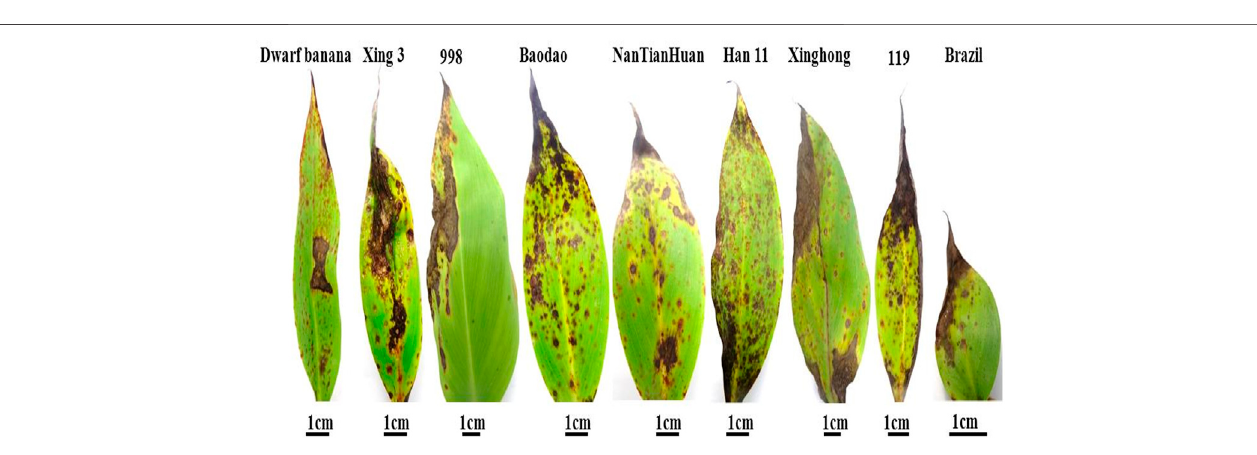
FIGURE 2 | Symptoms of R07 isolate on nine different banana varieties. The symptoms were observed at 12 days post-inoculation.